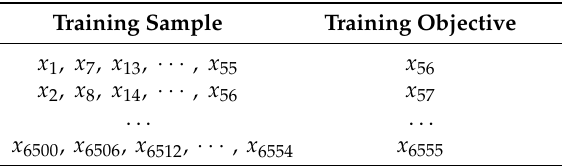
Table 2. Training sample and training objective.